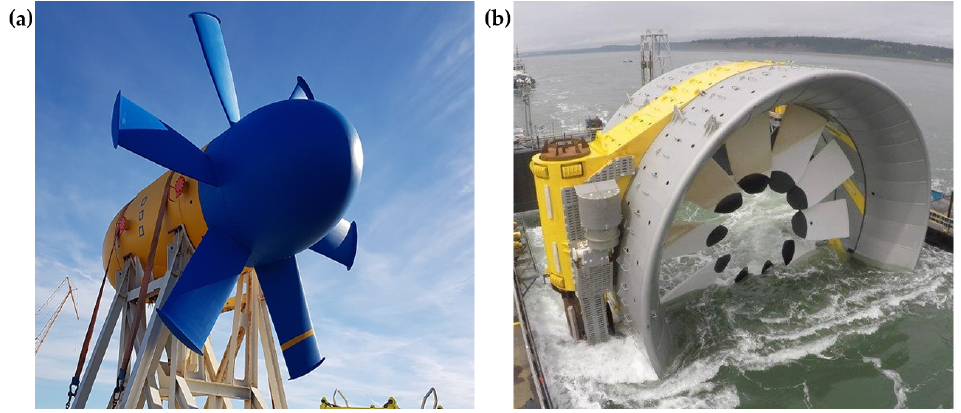
Figure 9. Two direct-drive TCEC structures: ( a ) the pod-type structure of a Sabella D10-1000 tidal current turbine and ( b ) the rim-driven structure of an OpenHydro tidal current